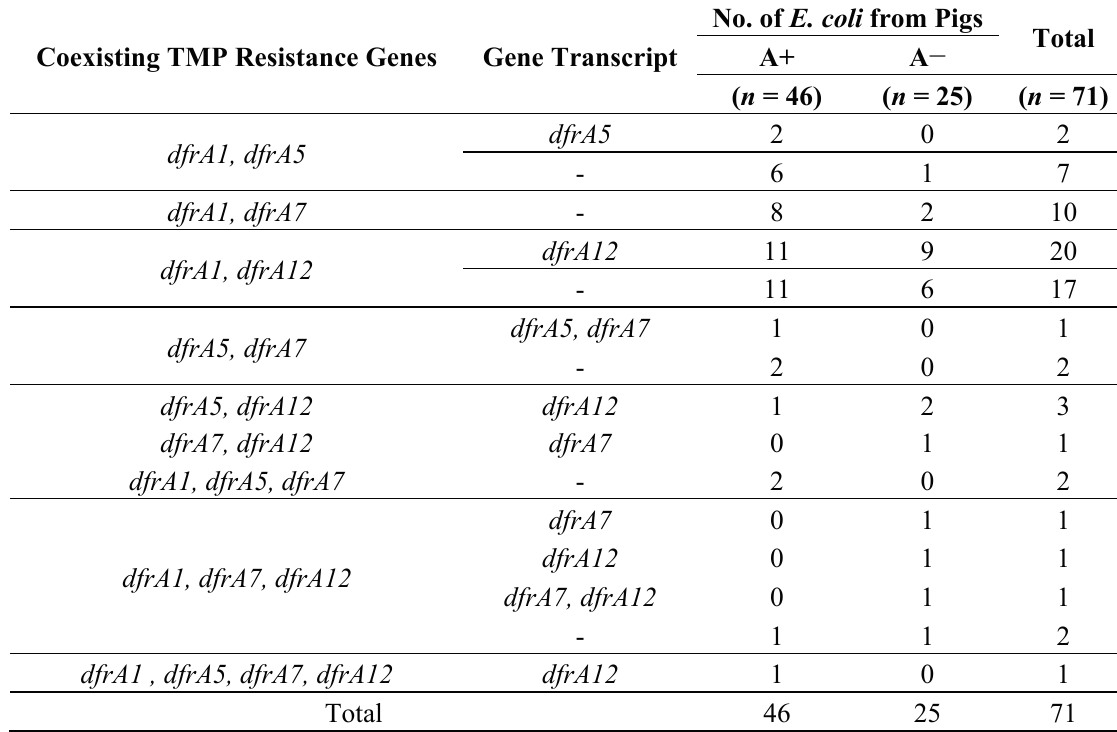
Table 4. Results of Real-time PCR transcription analyses of dfrA genes coexisting in single E. coli derived from groups of pigs during metaphylaxis (A+) and in post-exposure period (A −